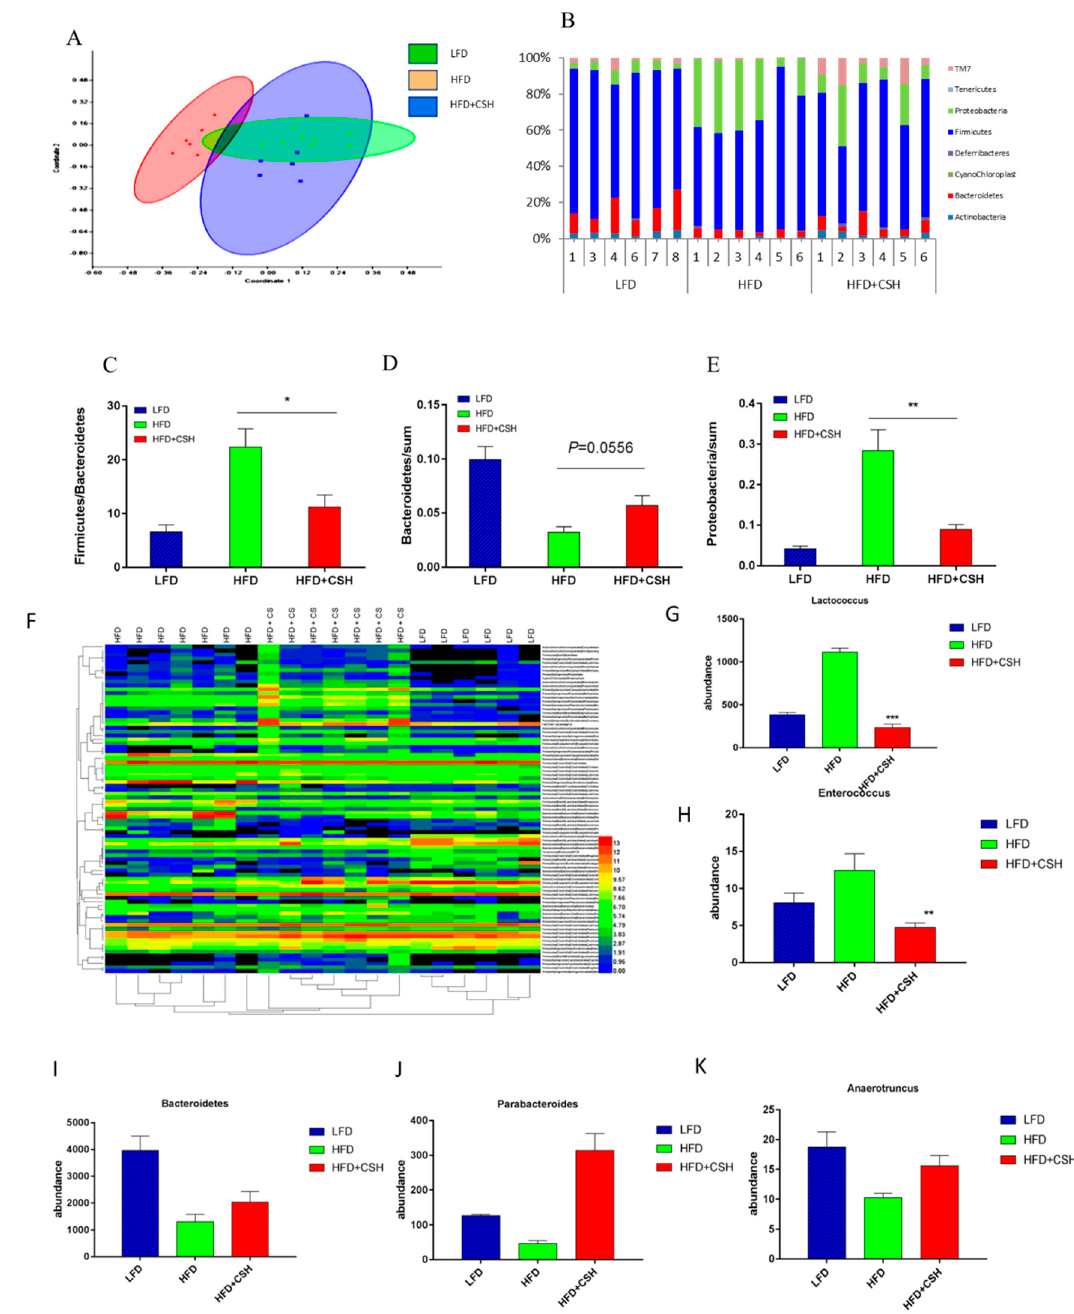
Figure 8. WECS modulates the composition of the gut microbiota. Microbiota composition in feces of HFD mice treated with or without 1% WECS and LFD mice were analyzed using next-generation sequencing ( n = 7 for each group). NMDS and Multivar / One-way ANOSIM analysis were used to explore the similarity between groups ( A ). Results of the bacterial taxonomic profiling at the phylum level of intestinal bacteria from different mouse groups ( B – E ). The heatmap shows that the abundance of 85 OTUs was significantly altered in HFD-fed mice ( F ). We also screened several representative microbes associated with obesity ( G – K ). Bars represent the mean + SEM, n = 6–7. * p < 0.05, ** p < 0.01, *** p < 0.01 compared with the HFD control.